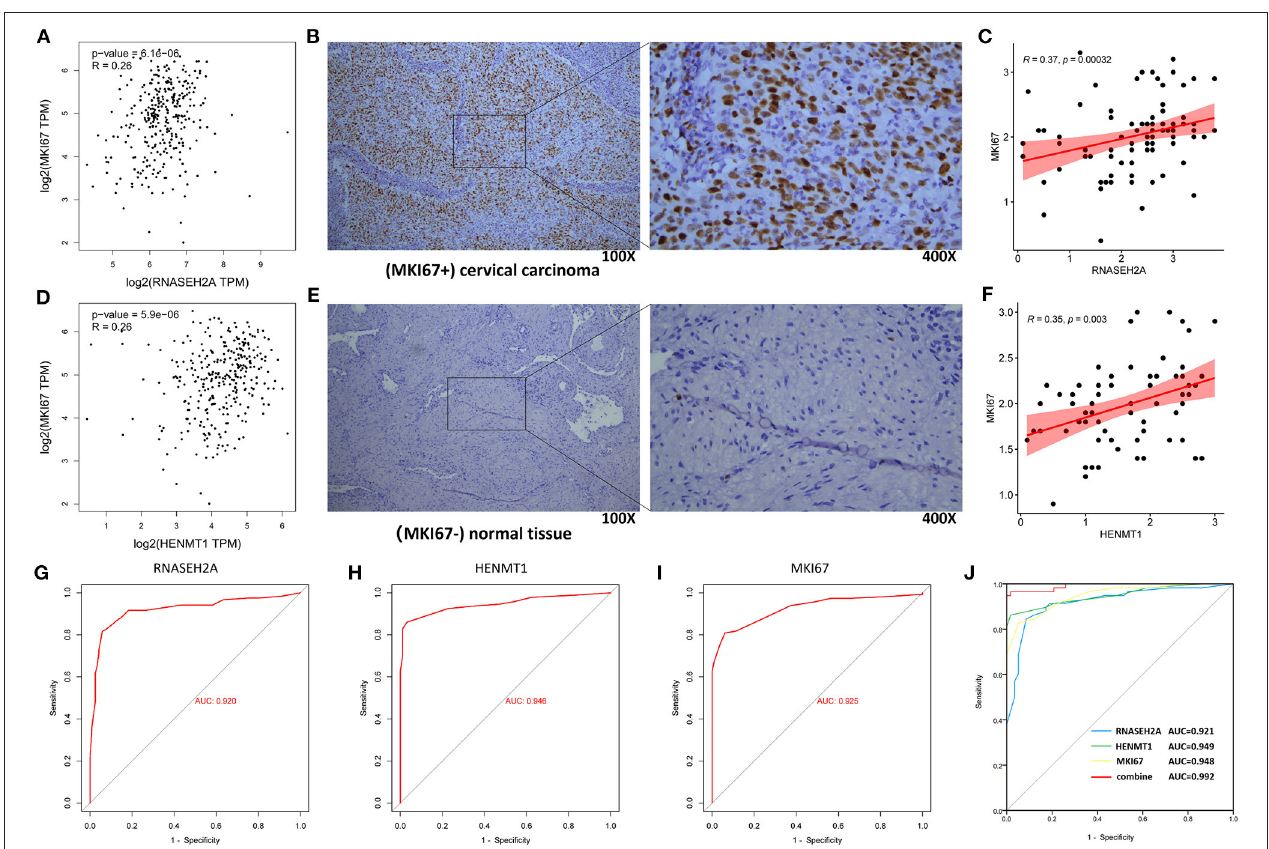
FIGURE 11 | Correlation analysis between RNASEH2A and HENMT1 and clinical marker MKI67, and evaluation of molecular diagnostic effect. (A,D) The correlation between RNASEH2A and HENMT1 and clinical markers (MKI67) in CESC was analyzed by GEPIA database. R represents the correlation coefficient. (B,E) Expression of clinical marker (MKI67) in cervical cancer and normal tissues. The brown part represents the target protein. (C) The correlation between RNASEH2A and clinical marker (MKI67) was analyzed according to the immunohistochemical results. (F) The correlation between HENMT1 and clinical marker (MKI67) was analyzed according to the immunohistochemical results. (G–I) ROC curve was used to analyze the diagnostic effect of RNASEH2A, HENMT1 and MKI67 on cervical cancer. (J) The efficacy of RNASEH2A and HENMT1 combined with clinical marker (MKI67) in the diagnosis of cervical